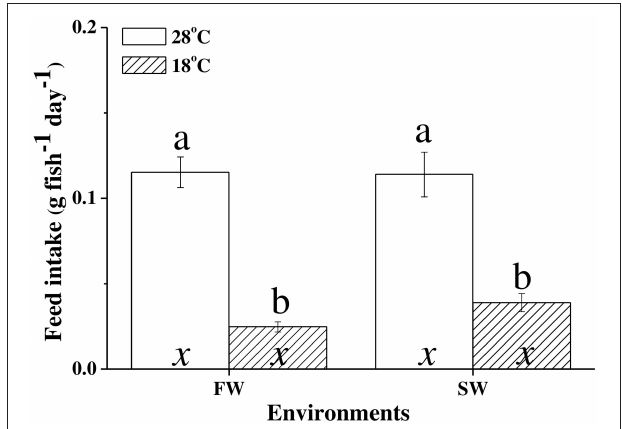
FIGURE 1 | Feed intake (g fish − 1 day − 1 ) between hypothermal freshwater (FW) and seawater (SW) milkfish. Value are means ± SEM, n = 8. Different letters (a vs. b) indicate significant differences between the 28 ◦ C and 18 ◦ C group at the same salinity, and the letter “x” indicate no significant difference between the FW and SW group at the same temperature. The TukeyHSD pairwise comparison was used following two-way ANOVA, P <